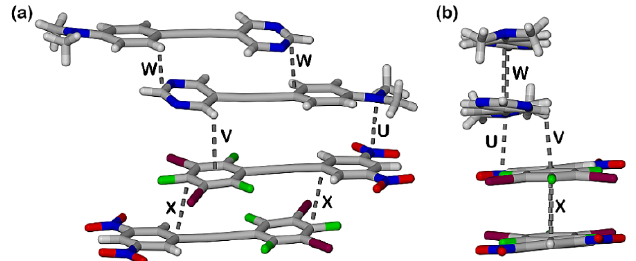
Figure 7. ( a ) Oblique view of the three unique stacking interactions 1-1, 1-3 and 3-3 in the